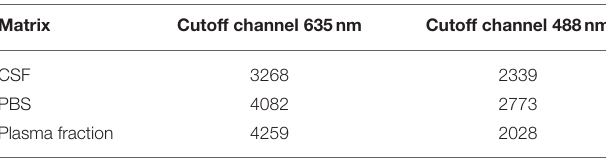
TABLE 1 | Cutoffs for the different body